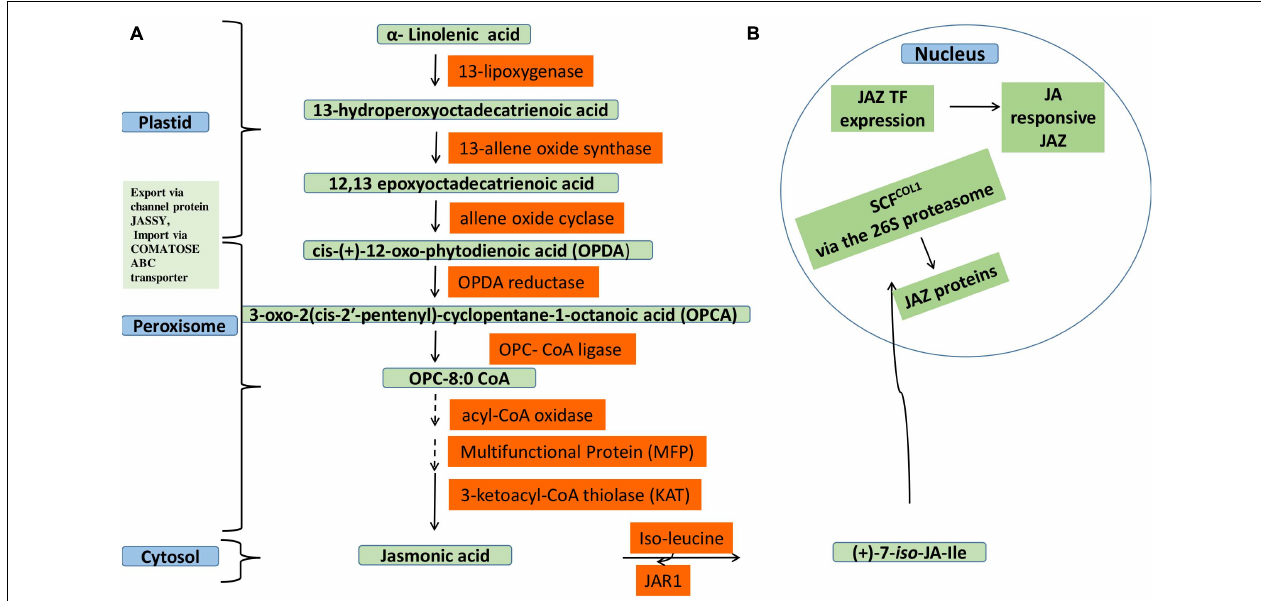
FIGURE 1 | Jasmonic acid biosynthesis and its gene regulation. (A) Jasmonic acid biosynthesis in various cellular compartments involving plastid, peroxisome and cytosol. In plastid α -linolenic acid is converted into 12-oxo-phytodienoic acid that is exported via JASSY channel protein and imported via COMATOSE ABC transporter to peroxisome. Subsequent reduction, β -oxidation, and epimerization reactions lead to JA formation and is released into cytosol. Then JA Conjugates with isoleucine in cytosol to form jasmonoyl–isoleucine (Ile-JA). (B) Degradation of JAZ repressor proteins via SCF COI 1 regulating JA gene expression at transcription level Ile-JA is in turn perceived Skip-Cullin–F-box complex (SCF COI 1 ) which mediates degradation of the JAZ repressor via 26S proteasome degradation, thereby relieving the repression by JAZ, transcriptional regulator.